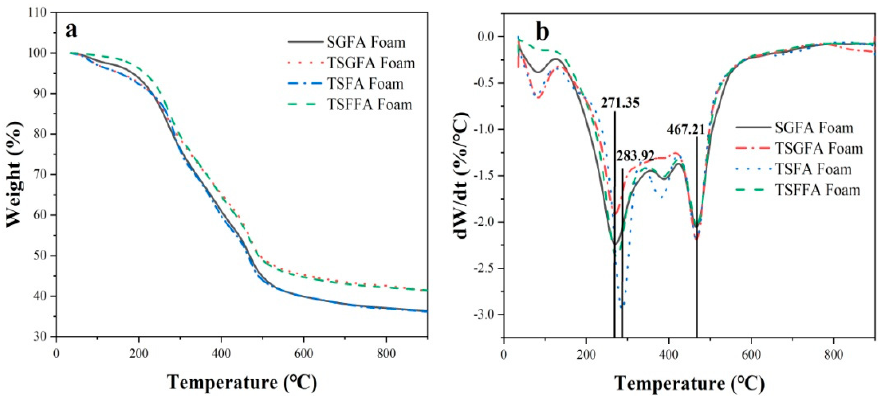
Figure 6. TGA ( a ) and DTG ( b ) curves of the various starch-based foams.